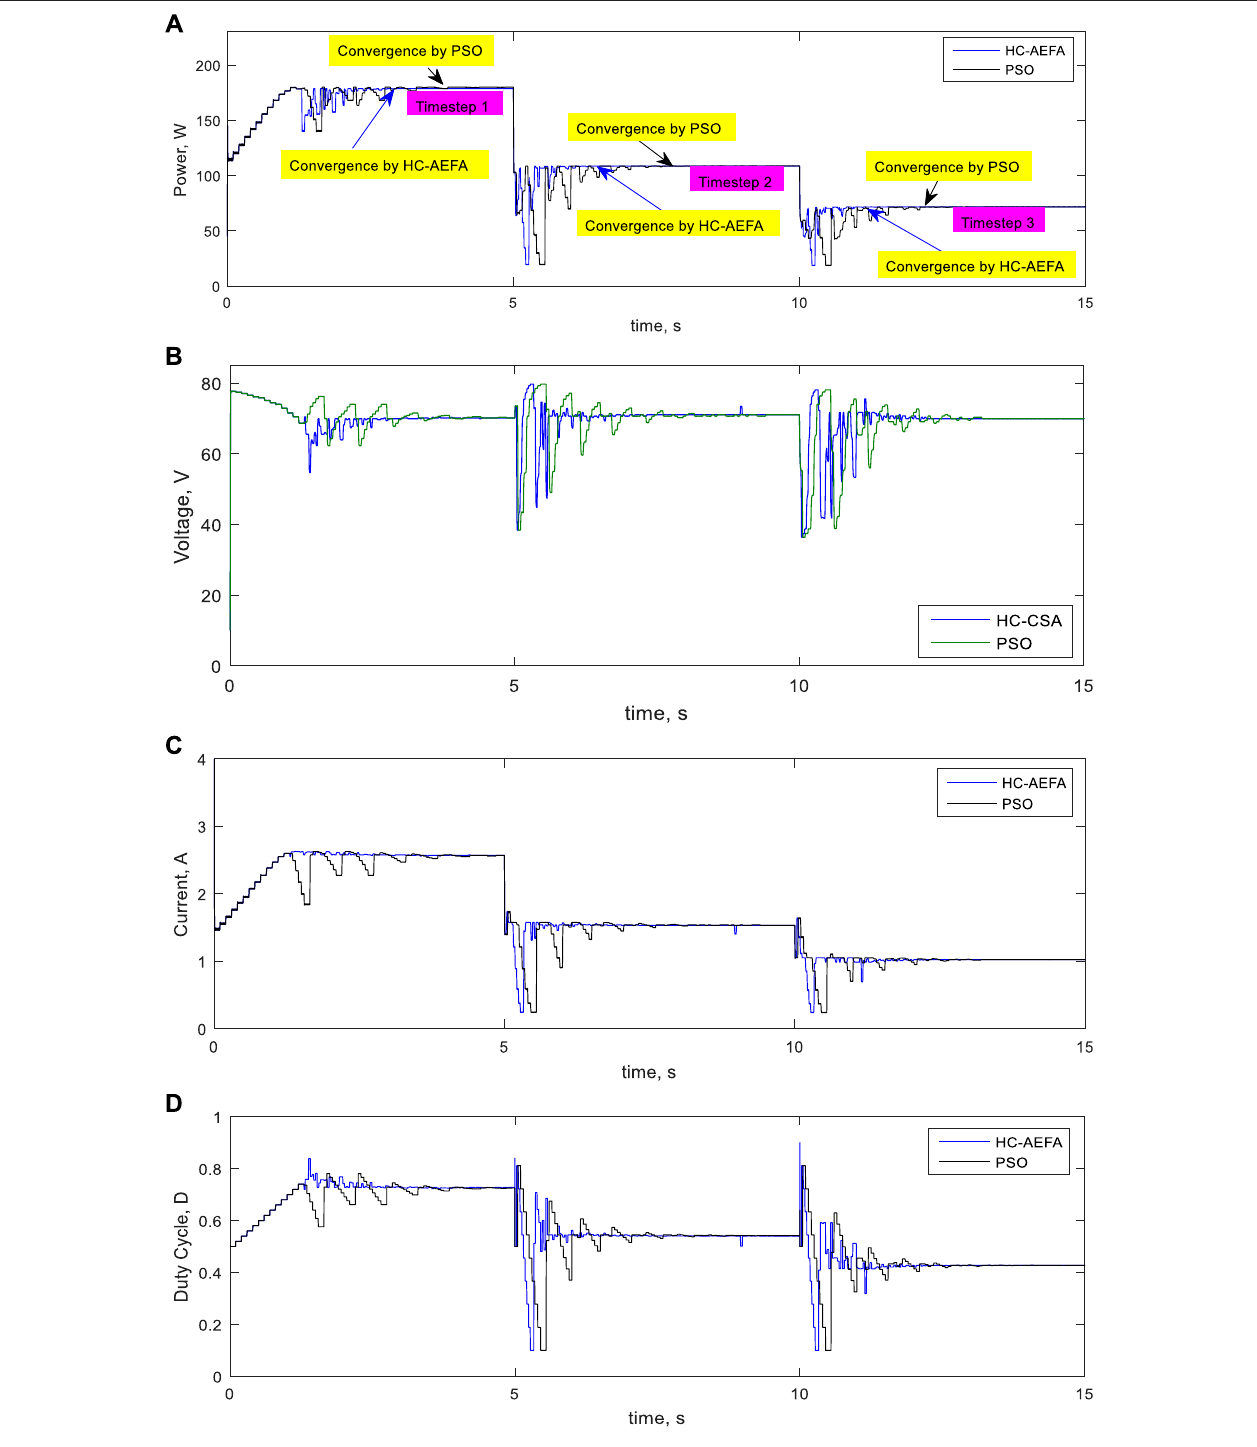
FIGURE 13 | Simulation waveforms at the fourth pattern obtained using the HC-AEFA, and PSO methods; (A) PV output power, (B) PV output voltage, (C) PV output current, and (D) converter duty-cycle curves.